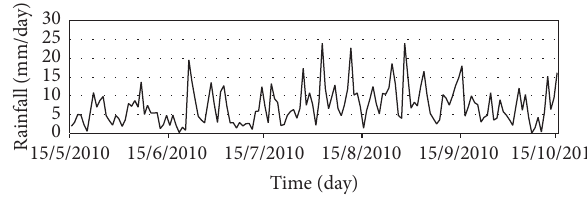
Figure 1: Mean rainfall (mm/day) during 15 May to 15 October 2010 at the 30